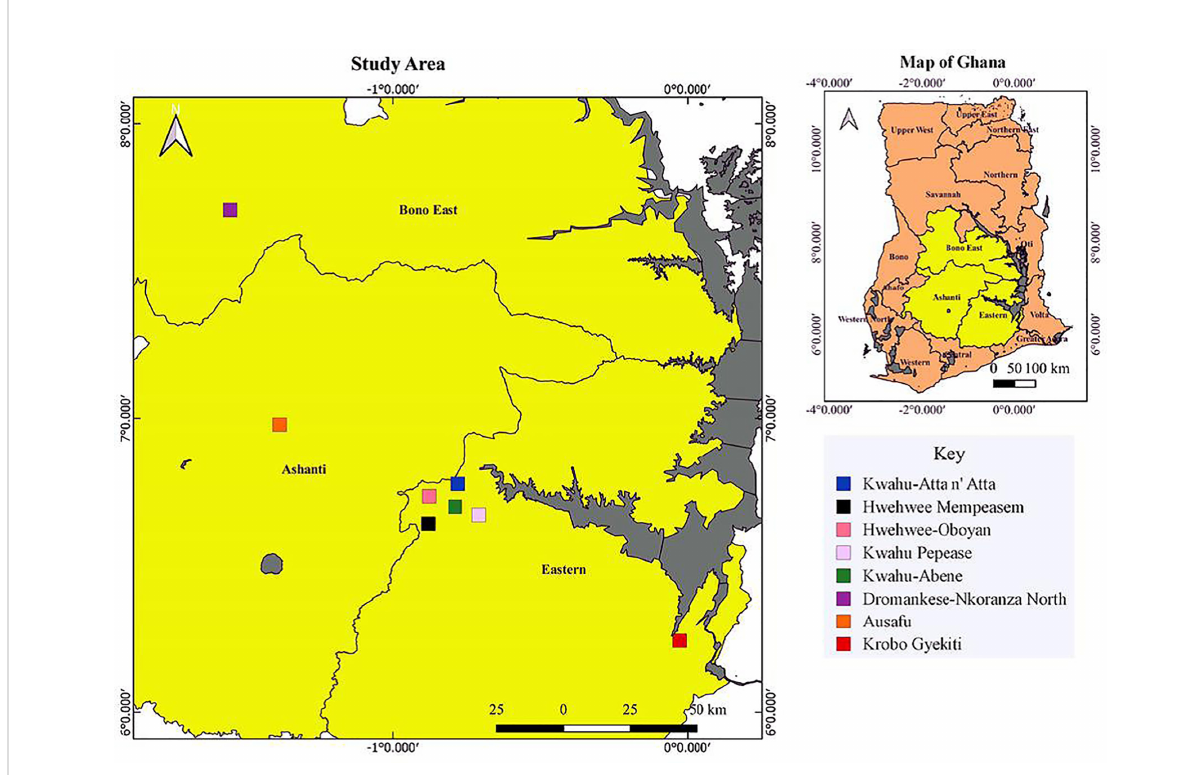
FIGURE 1 Distribution map of Cryptolepis sanguinolenta subpopulations across three different regions in